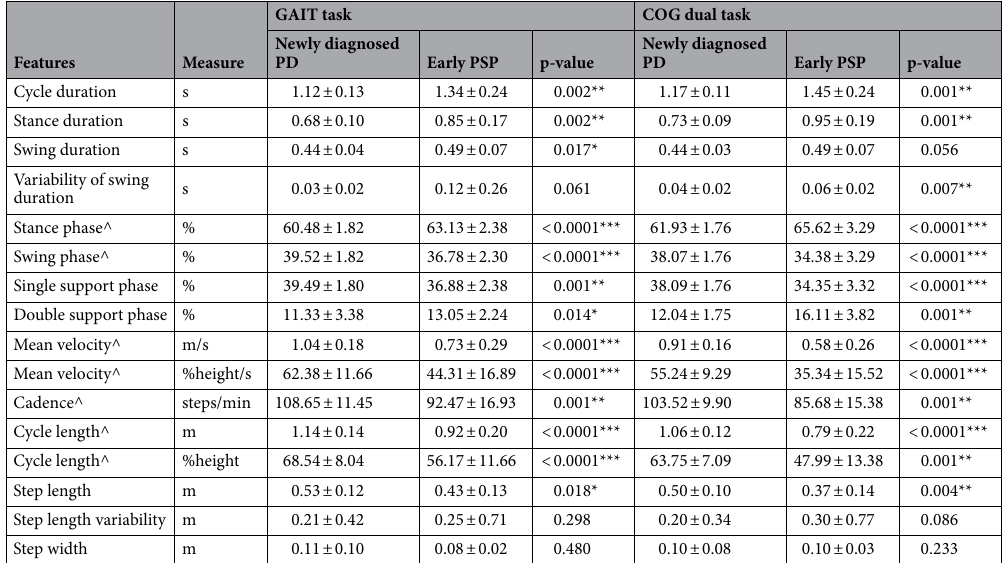
Table 5. Univariate statistical analysis comparing all gait parameters (mean ± SD) between newly diagnosed PD and early PSP patients. PD Parkinson’s disease, PSP progressive supranuclear palsy, SD standard deviation. *Significance level at 0.05. **Significance level at 0.01. ***Significance level at 0.001. ^Normally distributed according to the Shapiro Wilk test (homoscedasticity verified for all t-tests) and t-test applied; the other data were analyzed with a Mann Whitney